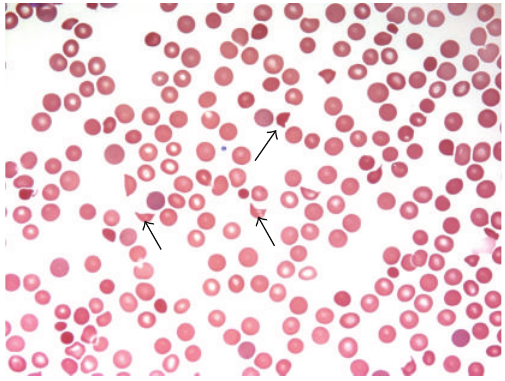
Figure 2: Peripheral smear of the patient demonstrating schisto- cytes